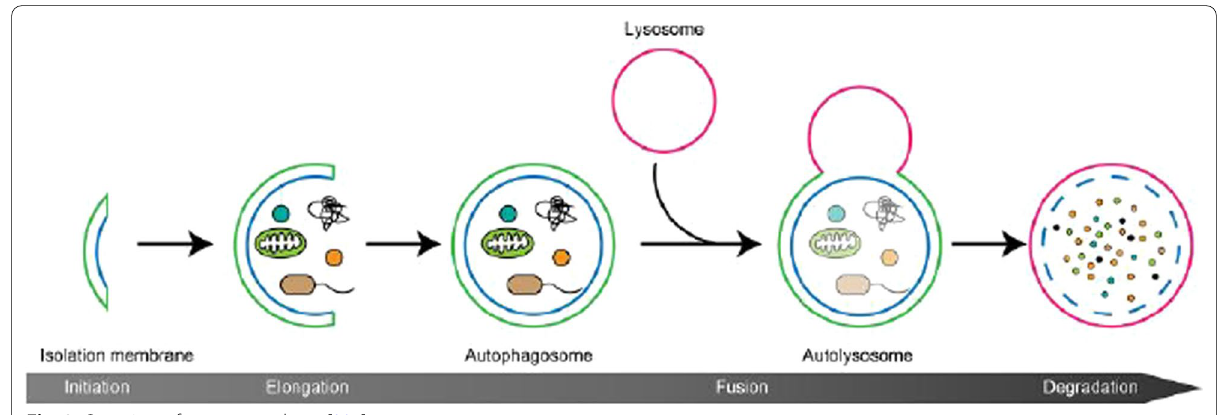
Fig. 2 Overview of macroautophagy